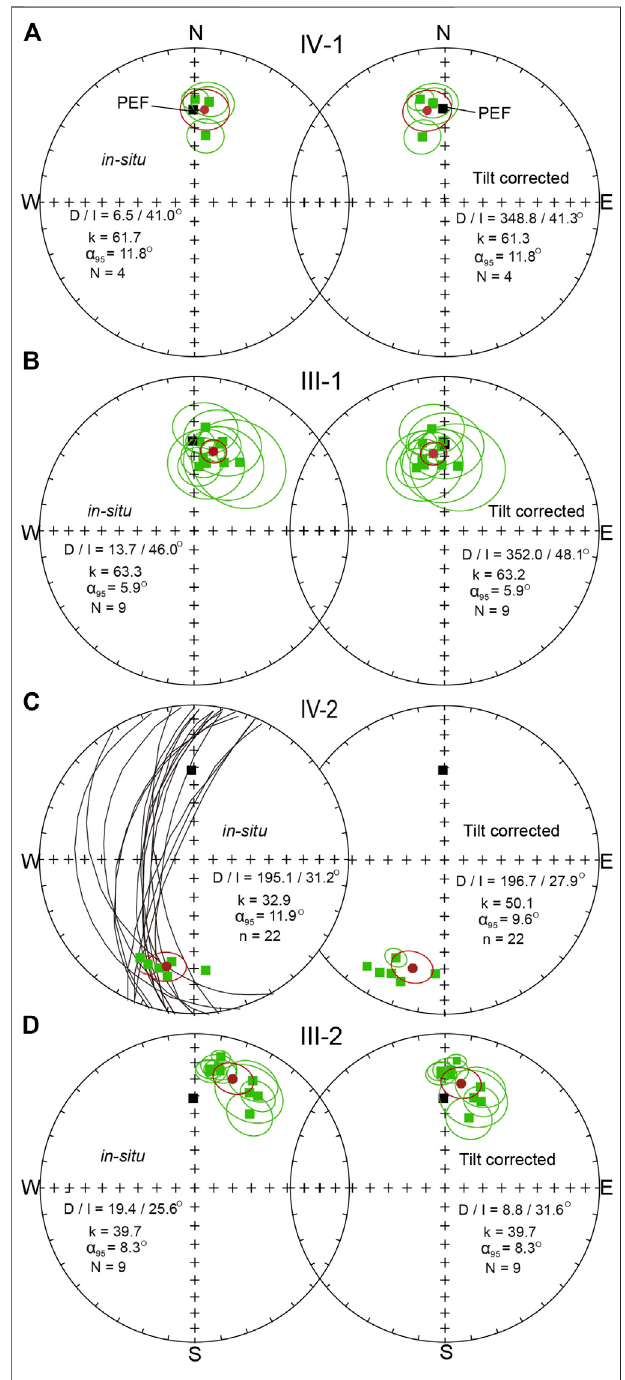
FIGURE7| Equal-areaprojectionsofpaleodirectionsbeforeandaftertilt correction. PEF: present Earth ’ s magnetic fi eld direction (black square). The ellipses indicate the95%con fi dence levelaboutthespecimen-meandirection (green square) or site-mean direction (red dot).